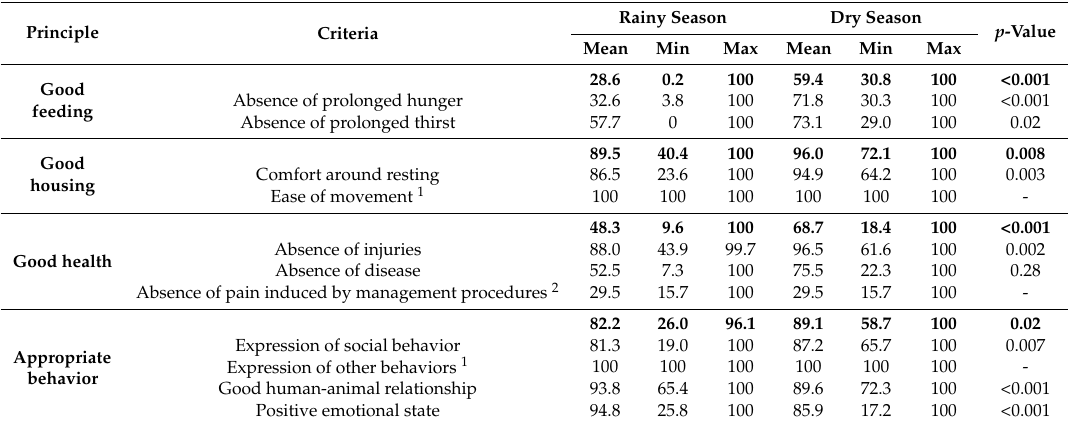
Table 4. Results of calculated scores for animal welfare principle and criteria levels in the Welfare Quality assessment on 45 farms during the rainy and dry season, respectively. Principle level scores highlighted in bold.